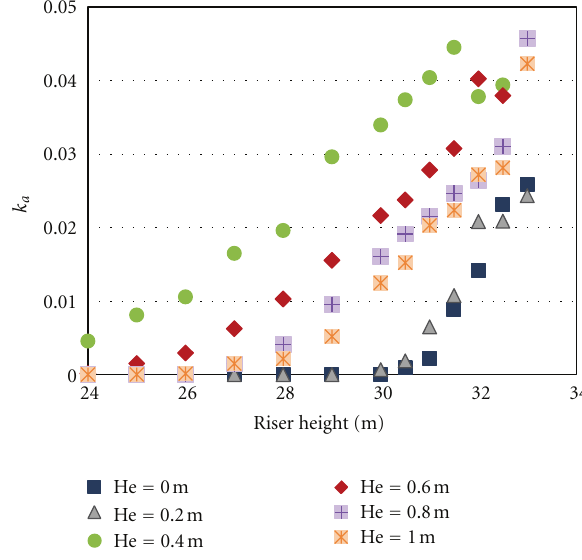
Figure 16: k a parameter obtained along the height for di ff erent projected